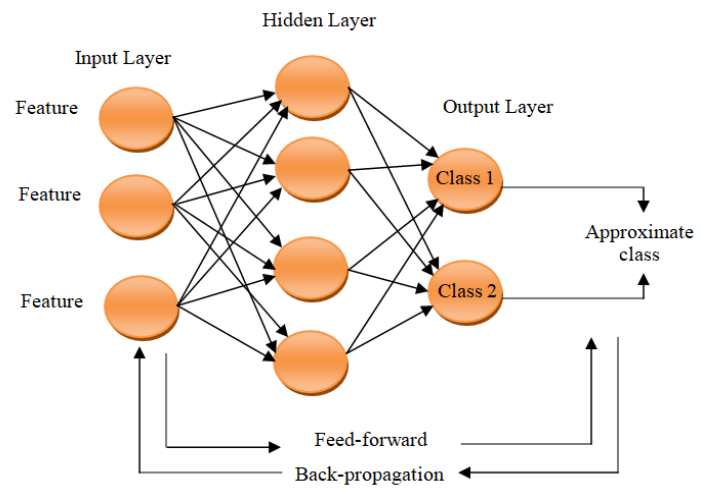
Figure 1. Conventional artificial neural network (ANN) architecture.